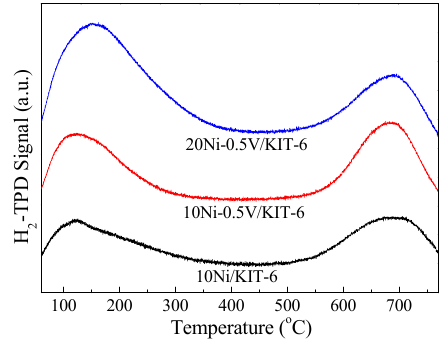
Figure 3. H 2 -TPD profiles of Ni-based catalysts.